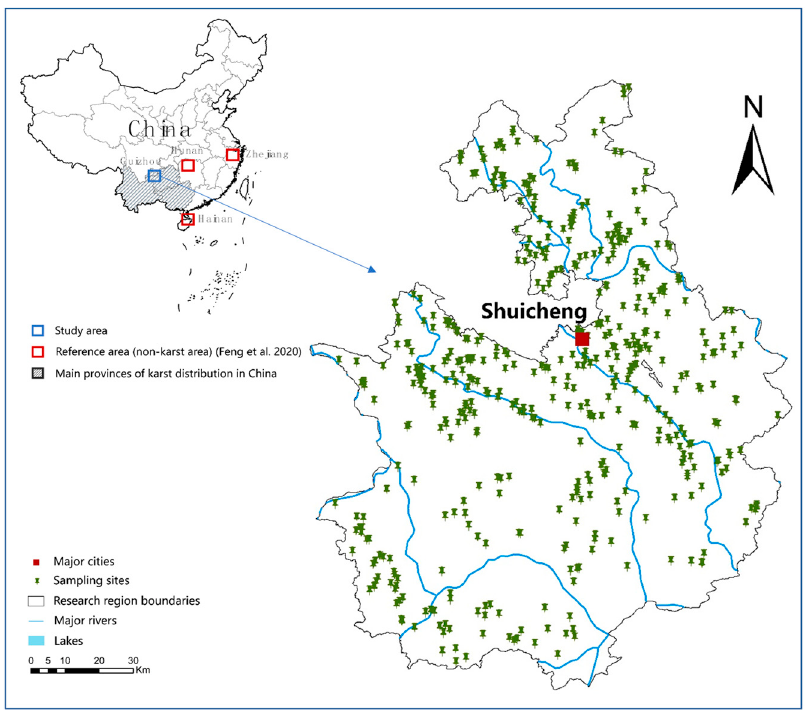
Figure 1. Distribution of sampling sites and locations of the study area and reference area [40].